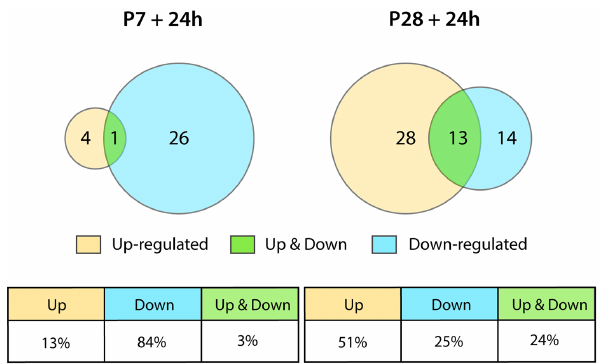
Figure 8. Summary of numbers of proteins that changed expression levels 24 h following spinal transection at P7 or P28. All but five of the proteins identified at P7 as showing a change in expression after injury were downregulated. At P28 half of the proteins were upregulated.